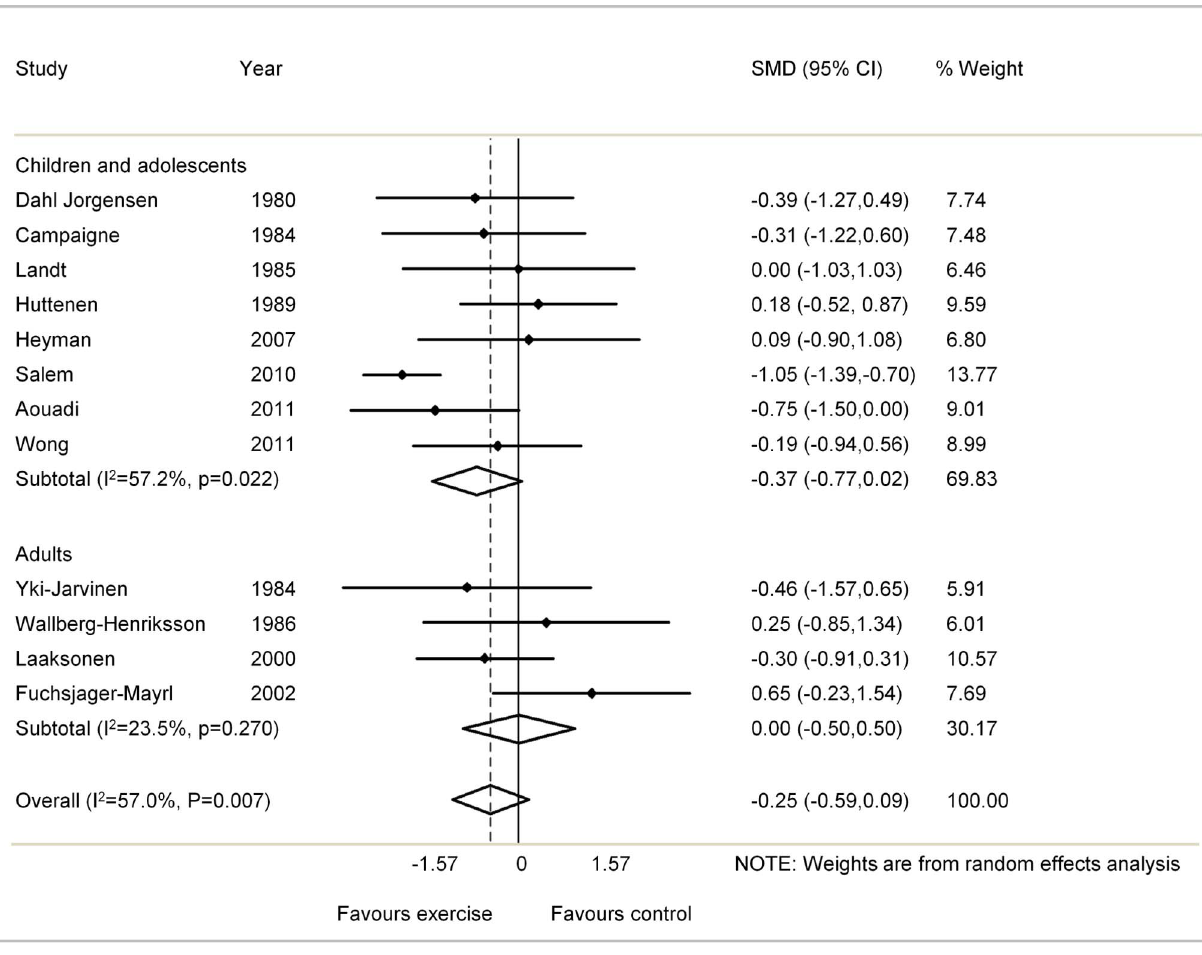
Figure 2. Results of studies of physical activity and glycaemic control (HbA1c) in type 1 diabetes patients according to age groups of participants.